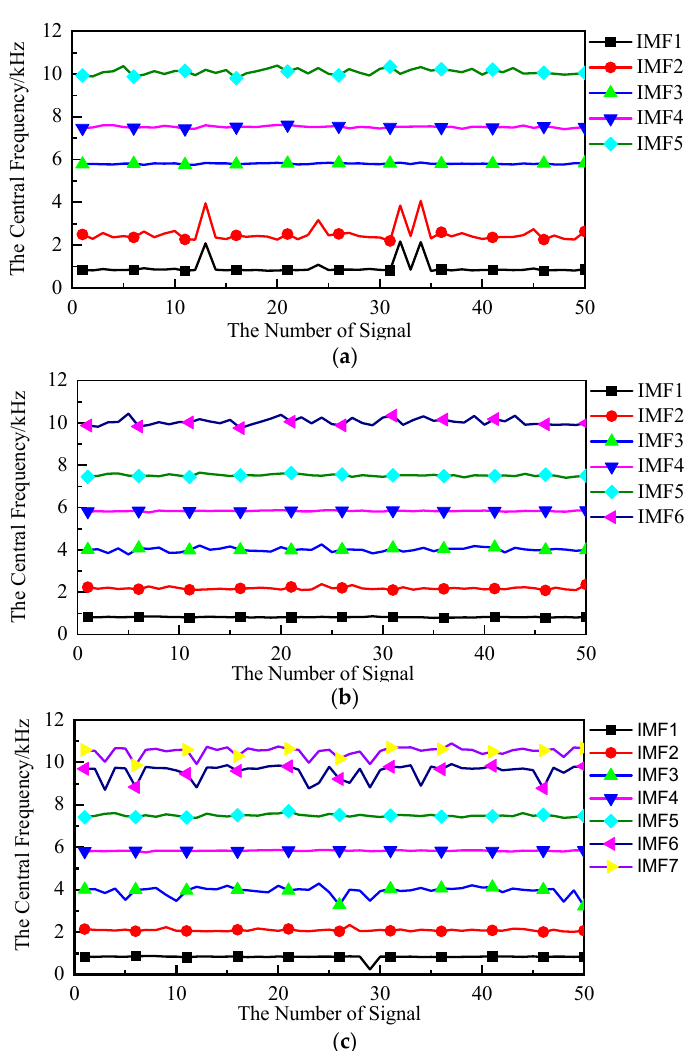
Figure 12. Central frequencies with different K values: ( a ) K = 5; ( b ) K = 6; ( c ) K = 7.